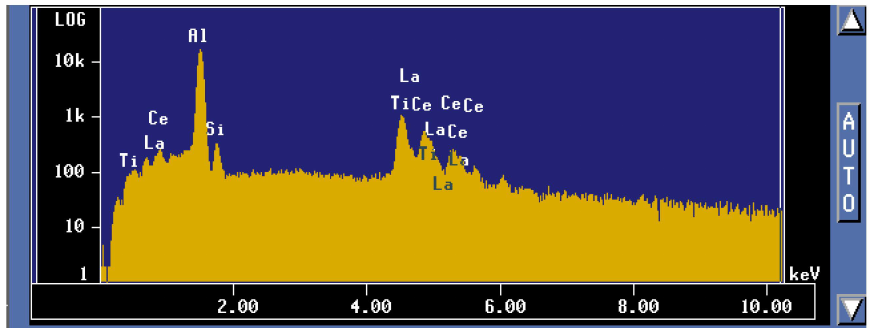
Figure 10. La, Si and Sr distribution in A356 alloy modified with 1.0% La + 0.01% Sr (T2S alloy).